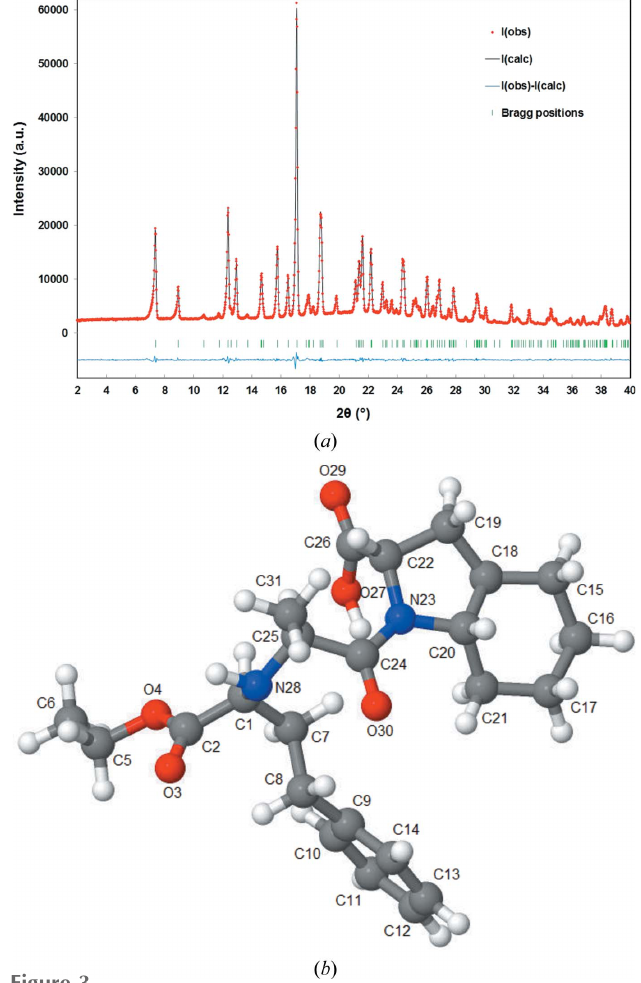
Figure 3 An example from the ICDD: ( a ) the high-quality powder diffraction data of the crystal structure of trandolapril (University College London) held in the PDF; ( b ) the crystal structure of trandolapril. Reproduced with the permission of Reid et al. (2016) and the journal Powder Diffraction